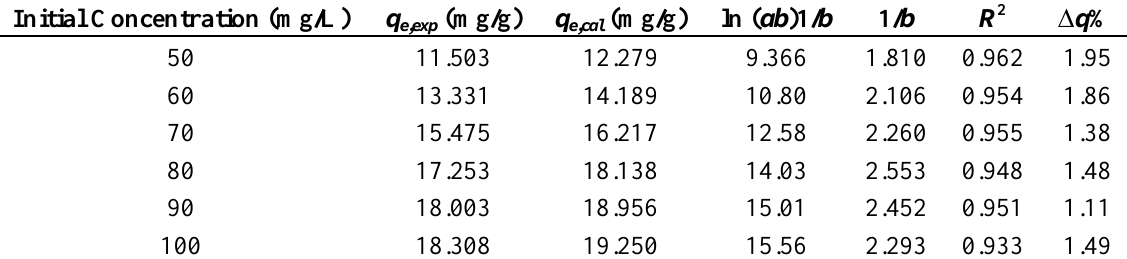
Table 4. The evaluation of the Elovich model constant at 30